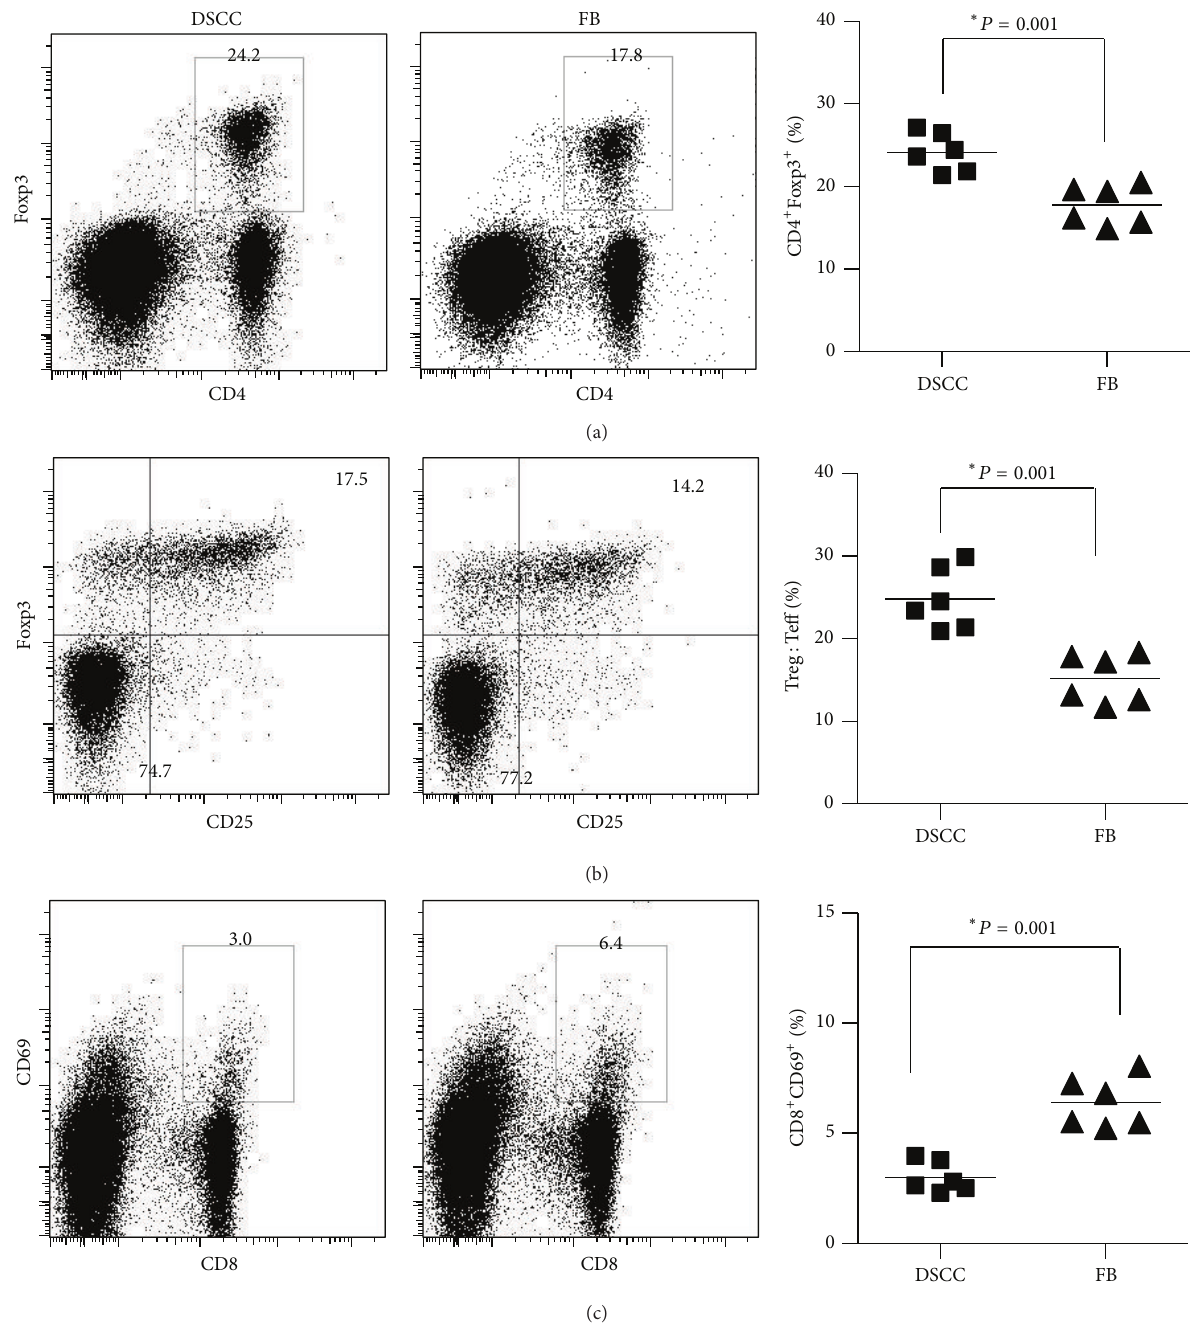
Figure 4: DSCC modulates immune responses in the draining lymph nodes of transplanted mice. Representative dot plots (left) and accumulating data (right) of CD4 + Foxp3 + (a), CD25 + Foxp3 + (b), and CD8 + CD69 + (c) cells from the renal lymph nodes of transplanted mice are shown. Each dot represents the result from one mouse in group 1 (DSCC and islets) or 2 (FB and islets) after 2 weeks (a, b) or 3 weeks (c) of transplantation. Pooled data (right) are shown as the means from six mice per experiment, with Student 𝑡 -test showing significance, ∗ 𝑃 < 0.05